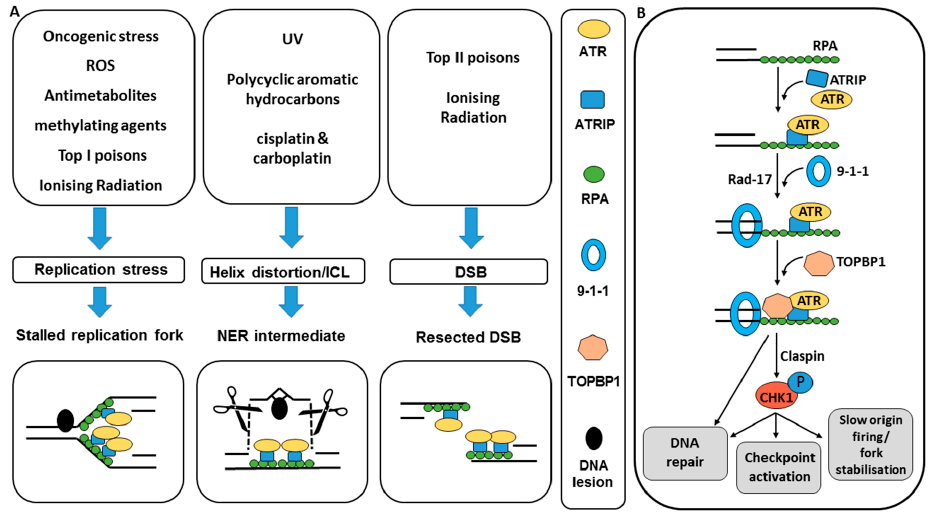
Figure 1. Induction of ATR-CHK1 pathway activation and downstream signalling. ( A ) Anti-